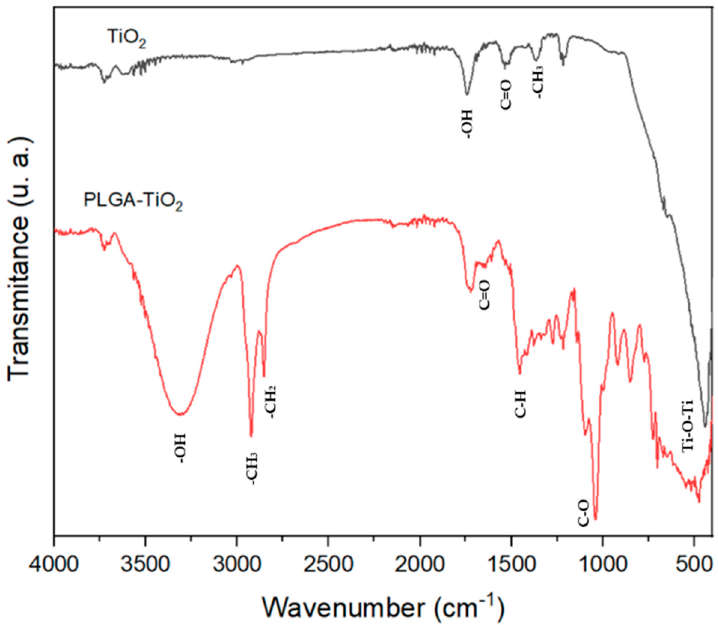
Figure 4. FT-IR spectra of pure titanium dioxide (TiO 2 ) and nanocomposite (PLGA–TiO 2